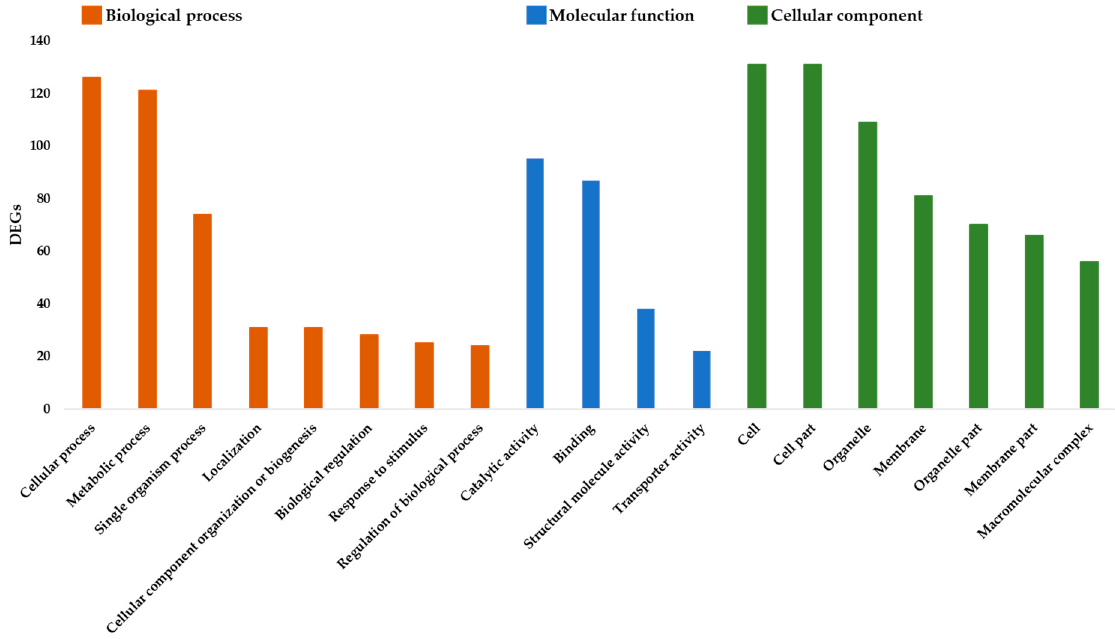
Figure 3. Functional annotation of the di ff erentially expressed genes using Gene Ontology terms.